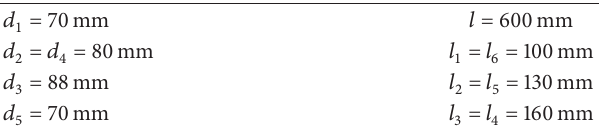
Table 4: Dimensions of the rotor-bearing